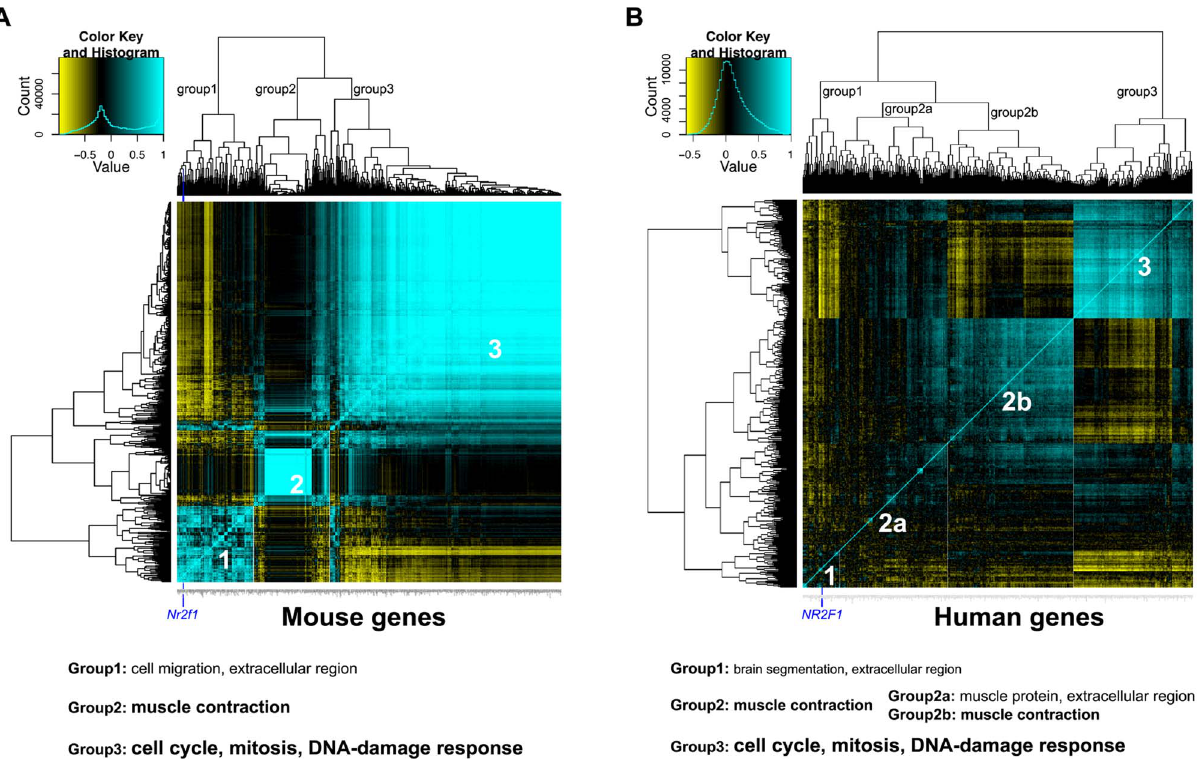
Figure 6. Global gene expression analysis reveals potential processes associated with Nr2f1/NR2F1 transcript levels. A) Heatmap of expression correlation clustering analysis of 412 genes (which have 1-1-1 mouse-rat-human orthologues) that are differentially expressed between mammary gland samples from megadeletion (MD) and wild type mice (WT), both FVB. B) Heatmap of expression correlation clustering analysis of the same 412 genes in 243 human breast cancers from GSE3494, downloaded from the Gene Expression Omnibus. For both panels, strong correlation is indicated in blue, strong anti-correlation is indicated in yellow. The position of Nr2f1/NR2F1 in group 1 is indicated by a dark blue vertical line. Below the panels, a summary of the gene ontology enrichment analysis is given. Smaller print indicates weak enrichment, larger print indicates strong enrichment (Tables S5, S6).